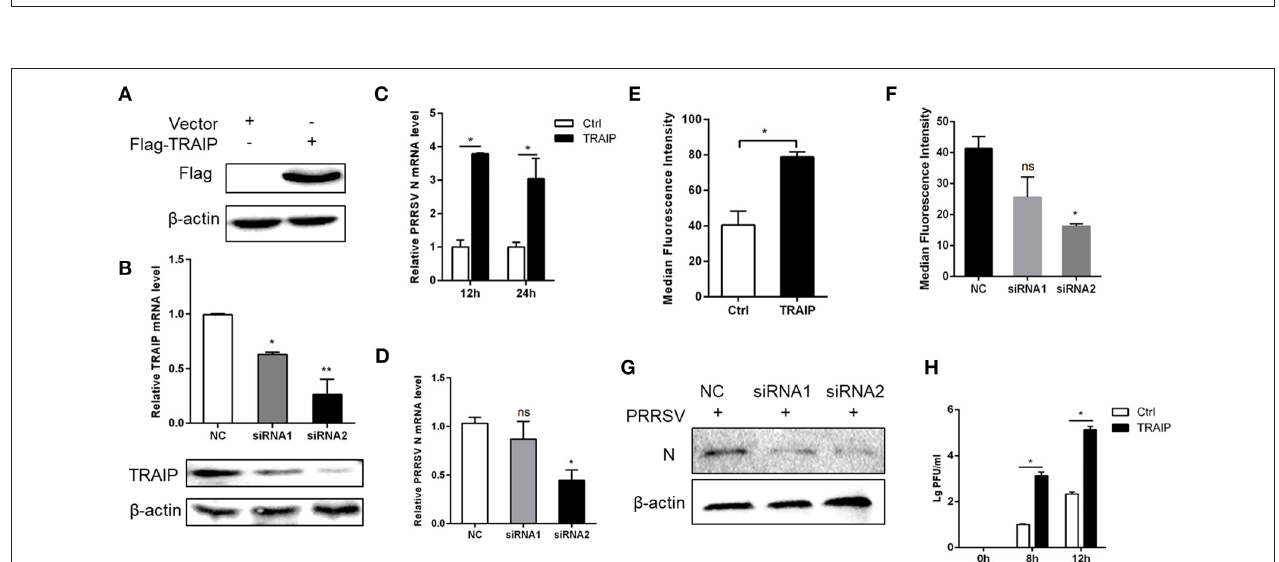
FIGURE 2 | TRAIP contributes to PRRSV proliferation. Flag-tagged TRAIP plasmid or negative control (NC) and siRNA1 (siTRAIP-1) or siRNA2 (siTRAIP-2) targeting TRAIP were transfected into 3D4/21 respectively at the indicated times (A–D) , after which the cells were infected with 0.5 MOI PRRSV and the cells were collected at 12 or 24h post-infection. Flag-TRAIP was recognized by the anti-FLAG tag antibody (A) and siRNA interference effects were detected by TRAIP polyclonal immunoblotting and qRT-PCR at post-transfection 24h (B) . The infected cells were collected at 12h (C–H) or 24h (C) post-infection, PRRSV N mRNA was detected by qRT-PCR, and PRRSV N was shown by WB analysis (G) . Analysis of PRRSV levels by flow cytometry detection of PRRSV N (E,F) . (H) PRRSV was inoculated after transfection with TRAIP and PRRSV load was tested by TCID50 after 8 or 12h. * P < 0.05, ** P < 0.01 (analysis of two-way ANOVA followed by Bonferroni post-test). Data are representative of three independent